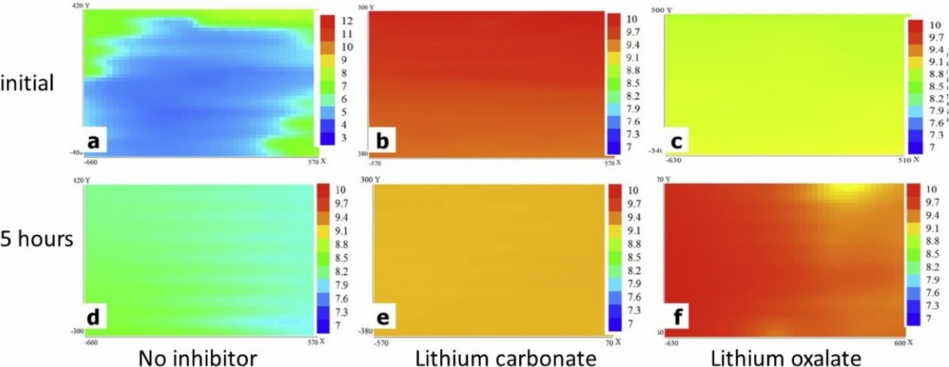
Figure 11. SIET pH scans of scribed area (1 mm × 2 mm): (1) for the initial stage after 5 min exposure for model coatings with ( a ) no inhibitor, ( b ) lithium carbonate, and ( c ) lithium oxalate and (2) after 5 h exposure with ( d ) no inhibitor, ( e ) lithium carbonate, and ( f ) lithium oxalate. Reproduced with permission of Elsevier